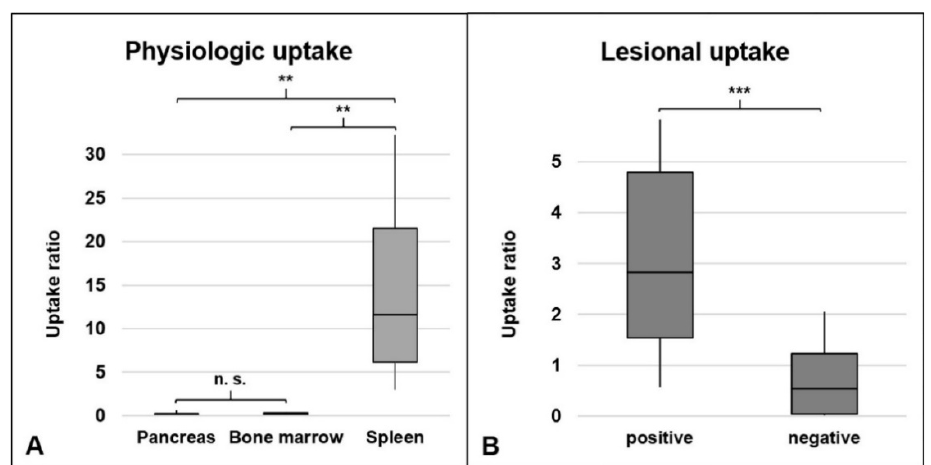
Figure 2. Uptake quantification in RBC scintigraphy in the overall group. ( A ) = Uptake in sites of physiologic uptake. ( B ) = Uptake in suspected splenic lesions. Referenced to liver uptake (uptake ratio). Positive = consensually rated as splenic tissue. Negative = consensually rated as non-splenic tissue. n.s. = not significant. ** p < 0.01, *** p < 0.001.